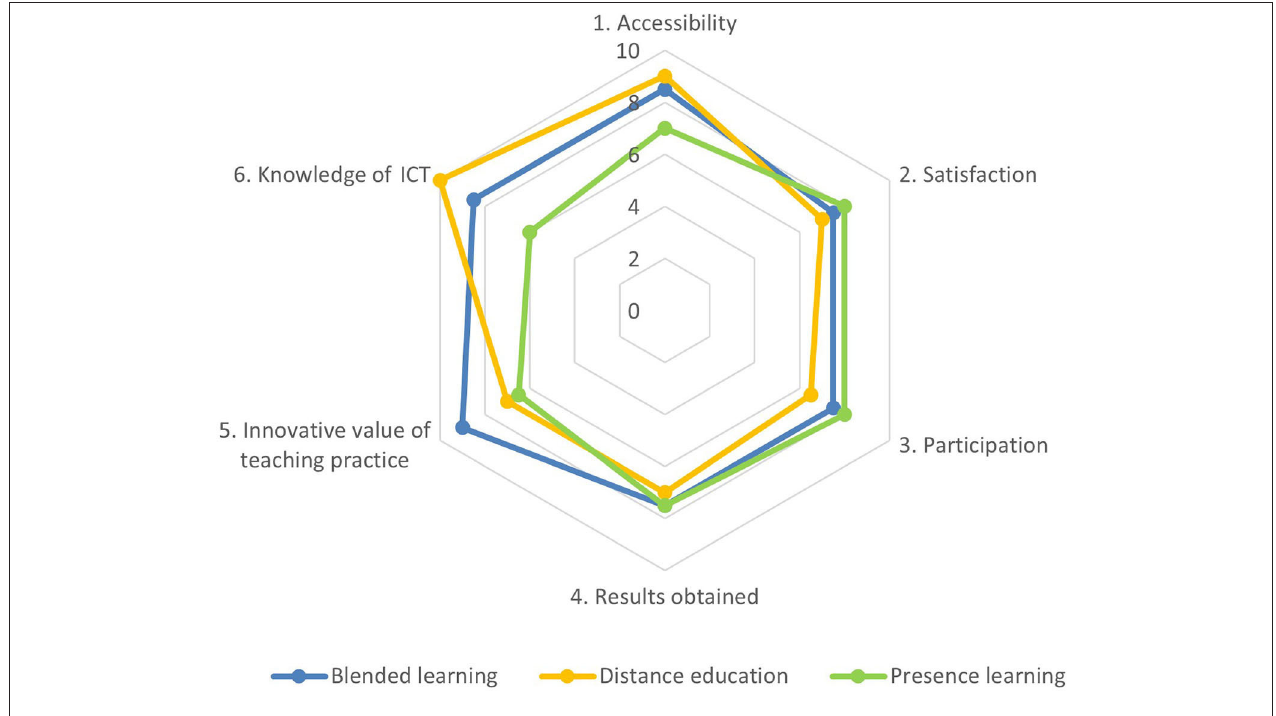
FIGURE 2 | Comparison of items in Study 1. Source: Own elaboration.